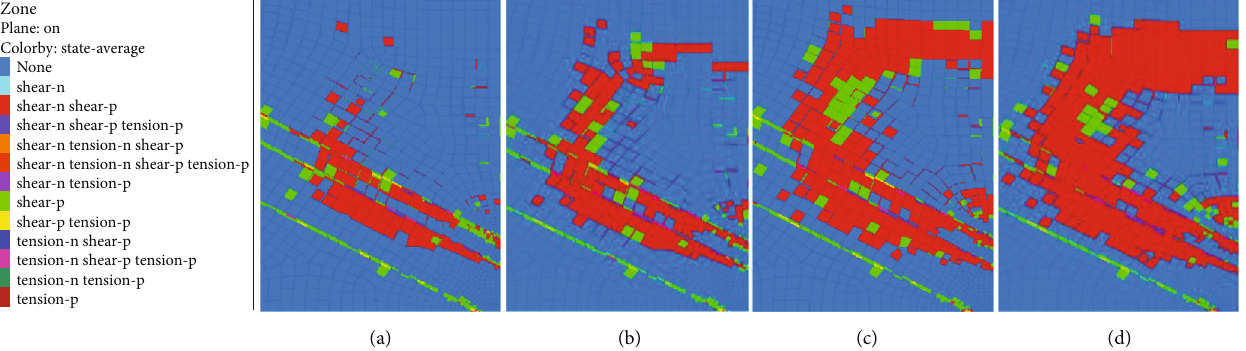
Figure 20: The plastic zone change of roadway roof in 302 mining area when the cutting position is 380m ahead of schedule. (a) Working face advancing 40m; (b) working face advancing 80 m; (c) working face advancing 120m; (d) working face advancing 160 m.